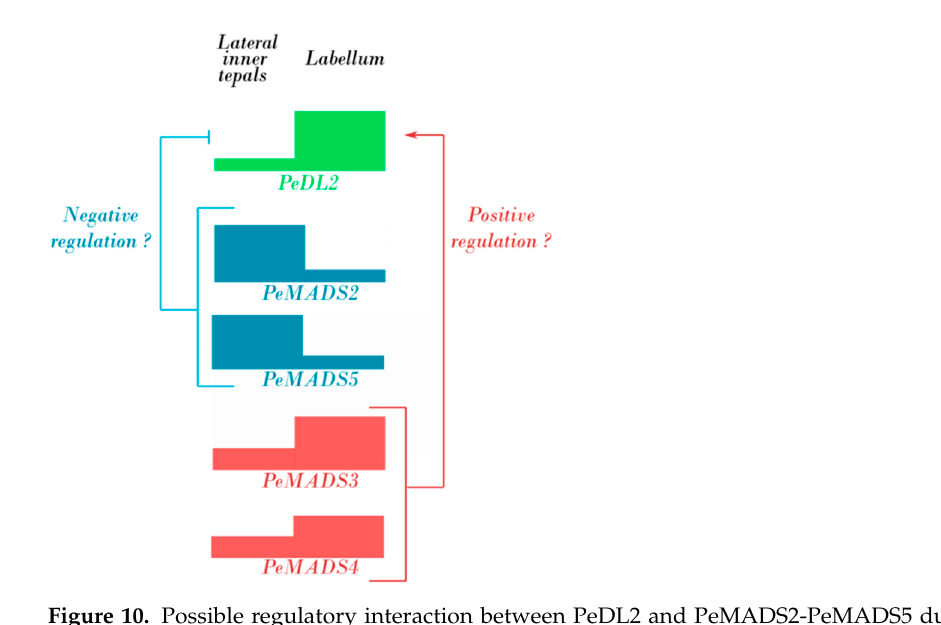
Figure 10. Possible regulatory interaction between PeDL2 and PeMADS2-PeMADS5 during the formation of the labellum of wild-type Phalaenopsis . formation of the labellum of wild-type Phalaenopsis